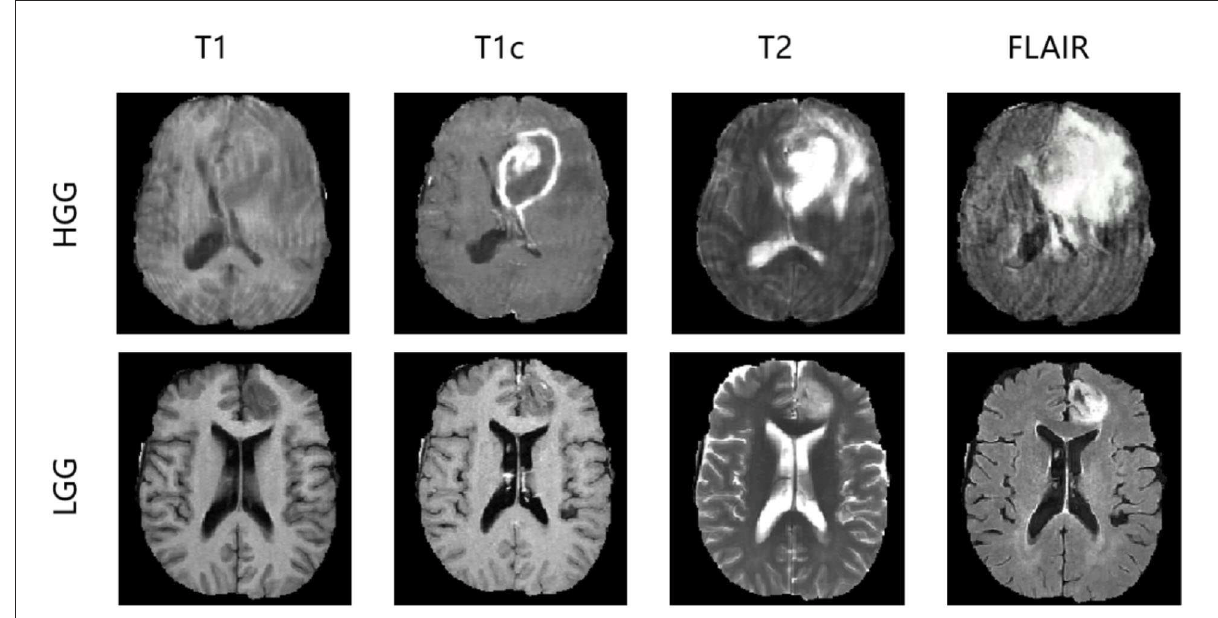
FIGURE3 HGG and LGG cases with four modalities: T1, T1c, T2, FLAIR on BRATS2015